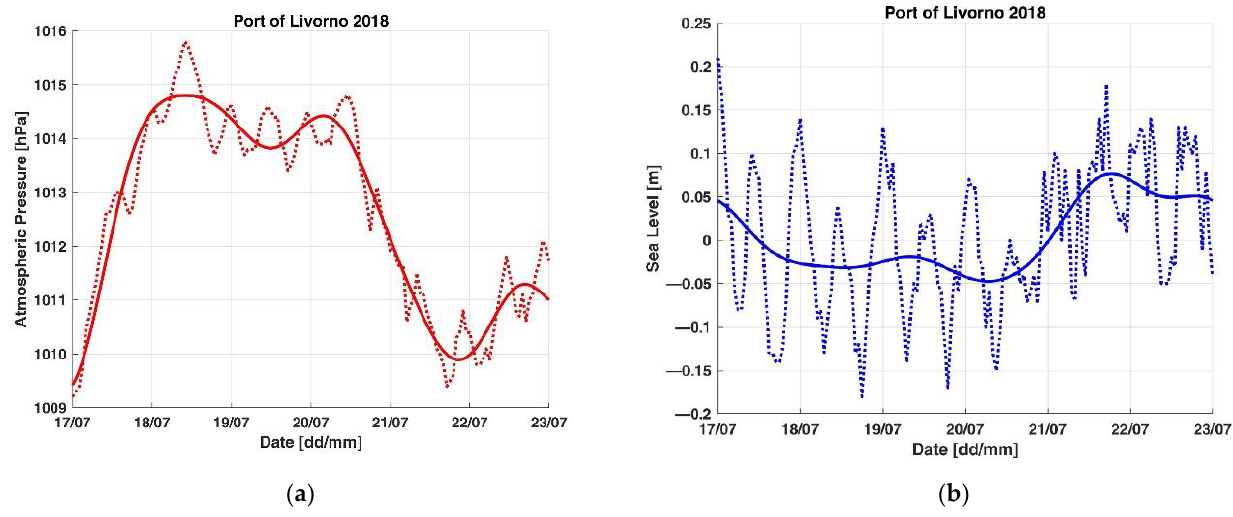
Figure A8. Low-frequency components of meteo-mareographic parameters acquired by ISPRA’s monitoring station in the port of Livorno from 17 to 23 July 2018: ( a ) atmospheric pressure; ( b ) sea level.